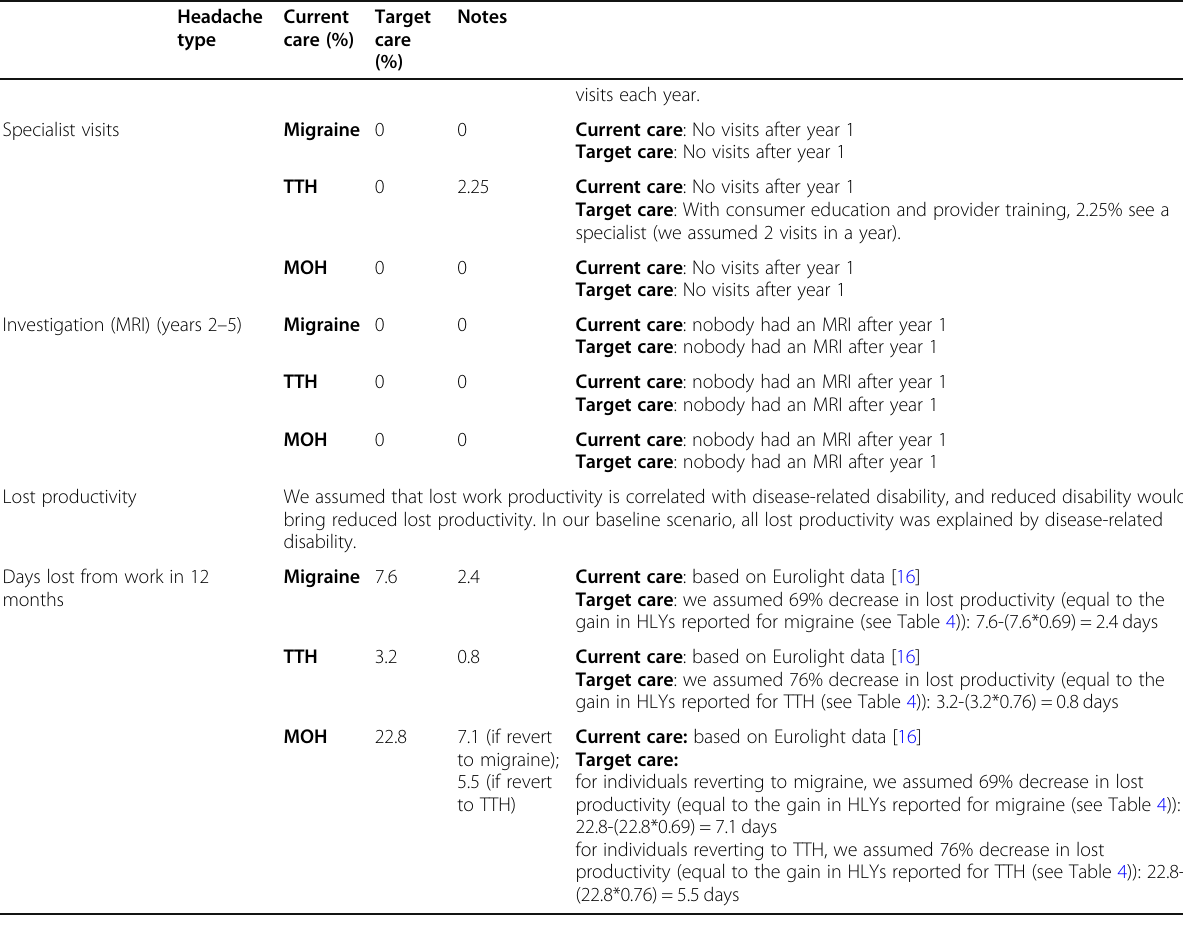
Decision-analytical models: treatment management plan and selection of interventions Figures 2, 3 and 4 represent the separate decision analyt- ical models developed and applied to the three country settings. The complete lists of medications, correspond- ing uptake estimates and assumptions made according to the different management plans (current and target alternatives) for the three headache types are set out in Tables 1, 2 and 3.